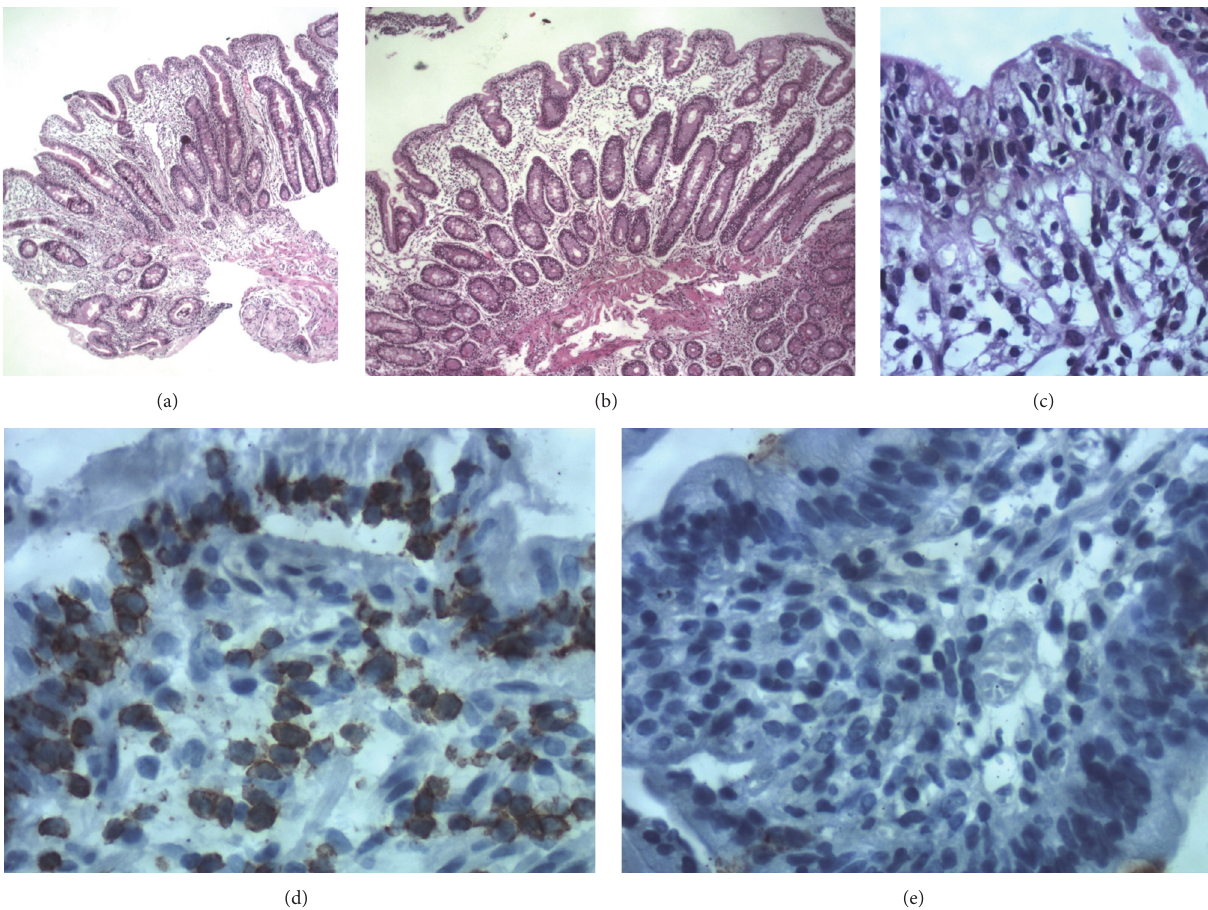
Figure 1: (a) Duodenal villous blunting, HE stain, 10x. (b) Duodenal villous blunting, oedema, HE stain, 10x. (c) Intraepithelial lymphocytosis and lack of plasma cells, HE stain, 10x. (d) Immunohistochemistry CD3-T lymphocytes positive. (e) Immunohistochemistry MUM 1 plasma cells